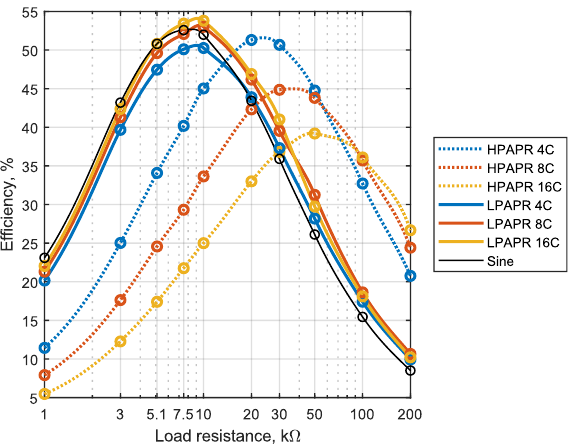
Fig. 10. RF-DC conversion efficiency for different load resistances and different signal waveforms.